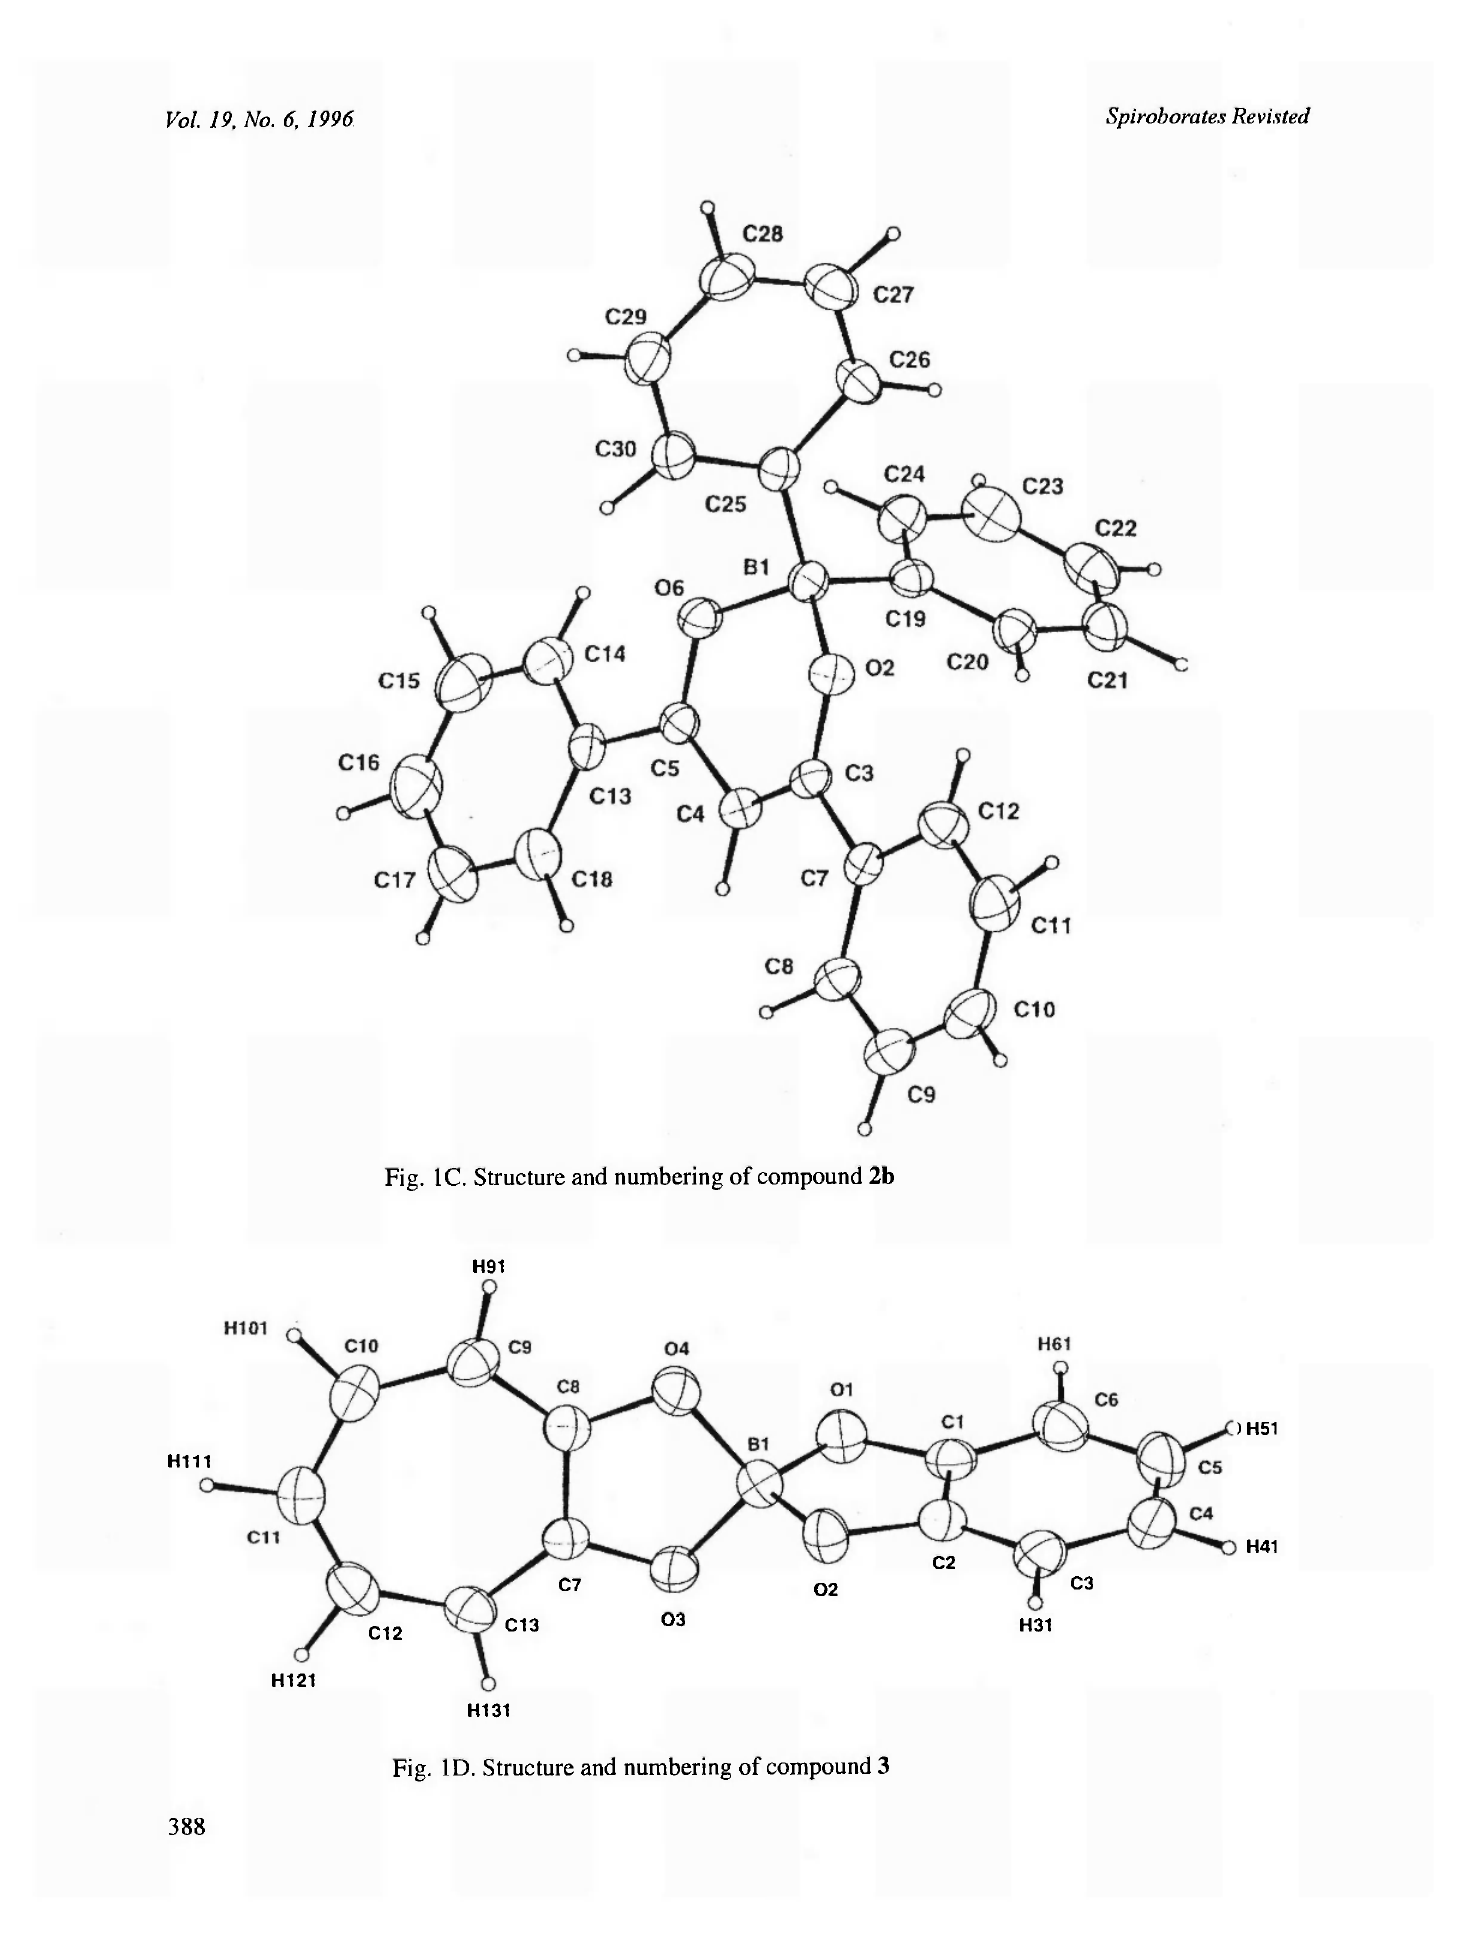
Fig. ID. Structure and numbering of compound